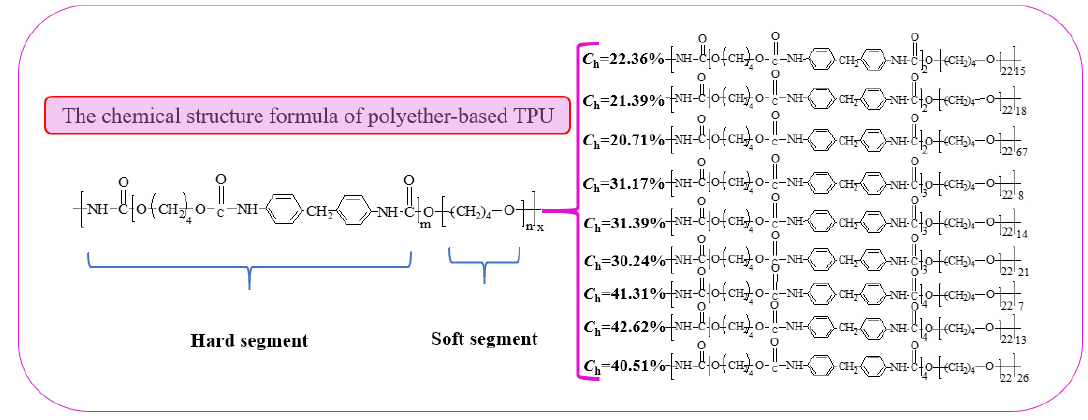
Figure 9. Chemical equation of polyether-based TPUs.